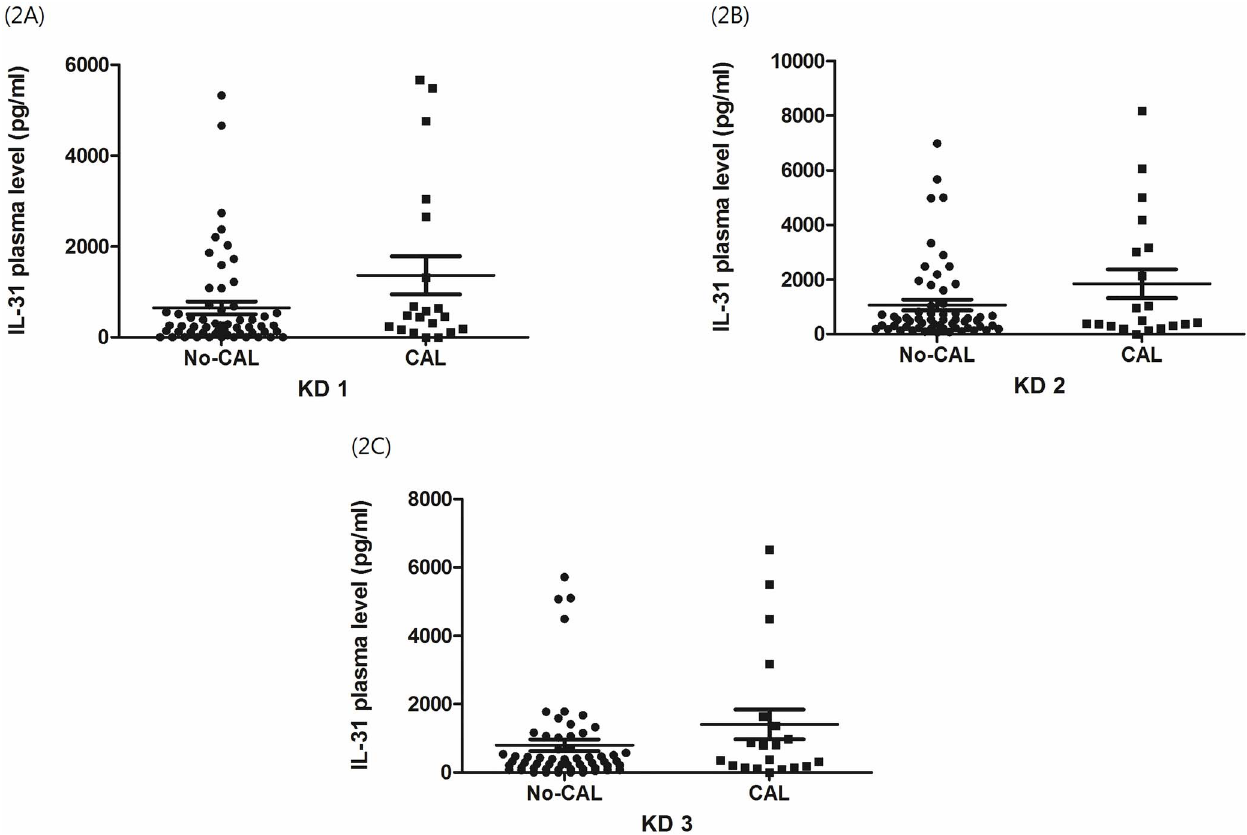
Figure 2. Increase of plasma interleukin-31 levels associated with coronary artery lesion formation in Kawasaki disease. Distribution of plasma levels of interleukin-31 (IL-31) before Intravenous immunoglobulin (IVIG) treatment (KD1), within 3 days after IVIG treatment (KD2) and at least 3 weeks after IVIG treatment (KD3). The display (2A) showed significant higher levels of IL-31 in Kawasaki disease patients with CAL formation before IVIG treatment (656.6 6 139.5 vs. 1373.0 6 422.0 pg/ml, p=0.04) when compared with without CAL formation. After IVIG treatment, plasma levels of IL-31 showed no significant difference between patients with or without CAL (2B and 2C).